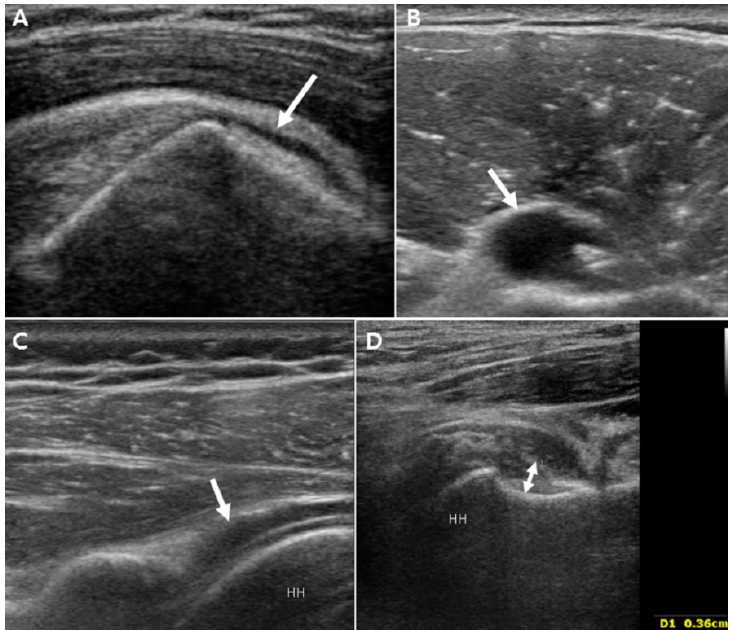
Figure 1. Illustrative grayscale ultrasonography images. ( A ) Subacromial/subdeltoid bursa (arrow) filled with fluid, ( B ) long head biceps tenosynovitis with effusion (arrow), ( C ) posterior glenohumeral synovitis with effusion (arrow), and ( D ) measurement of axillary pouch thickness to determine the presence of inferior glenohumeral synovitis (double arrow). HH , humeral head.